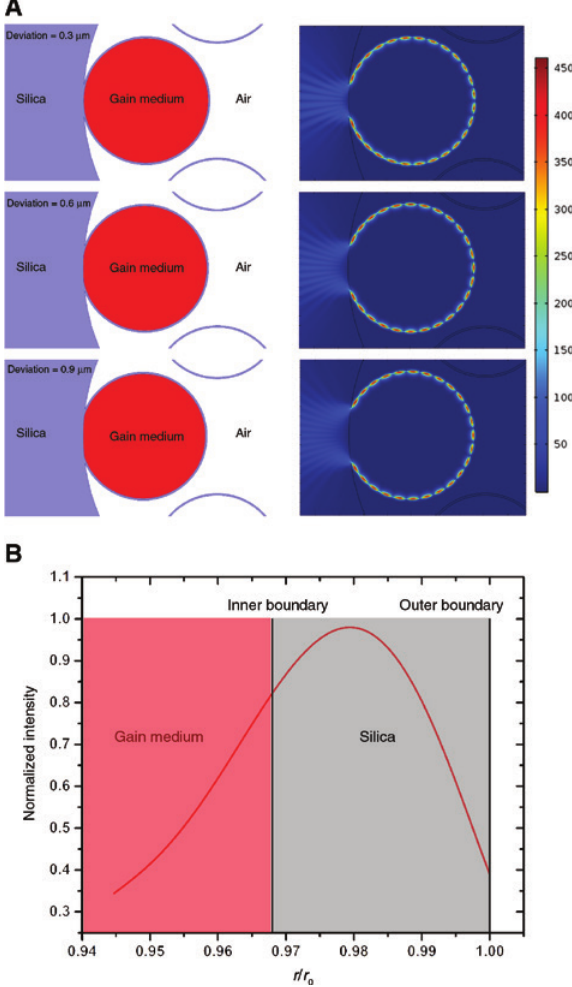
Figure 2: The conditions of typical energy distribution in the silica wall of the side-capillary.